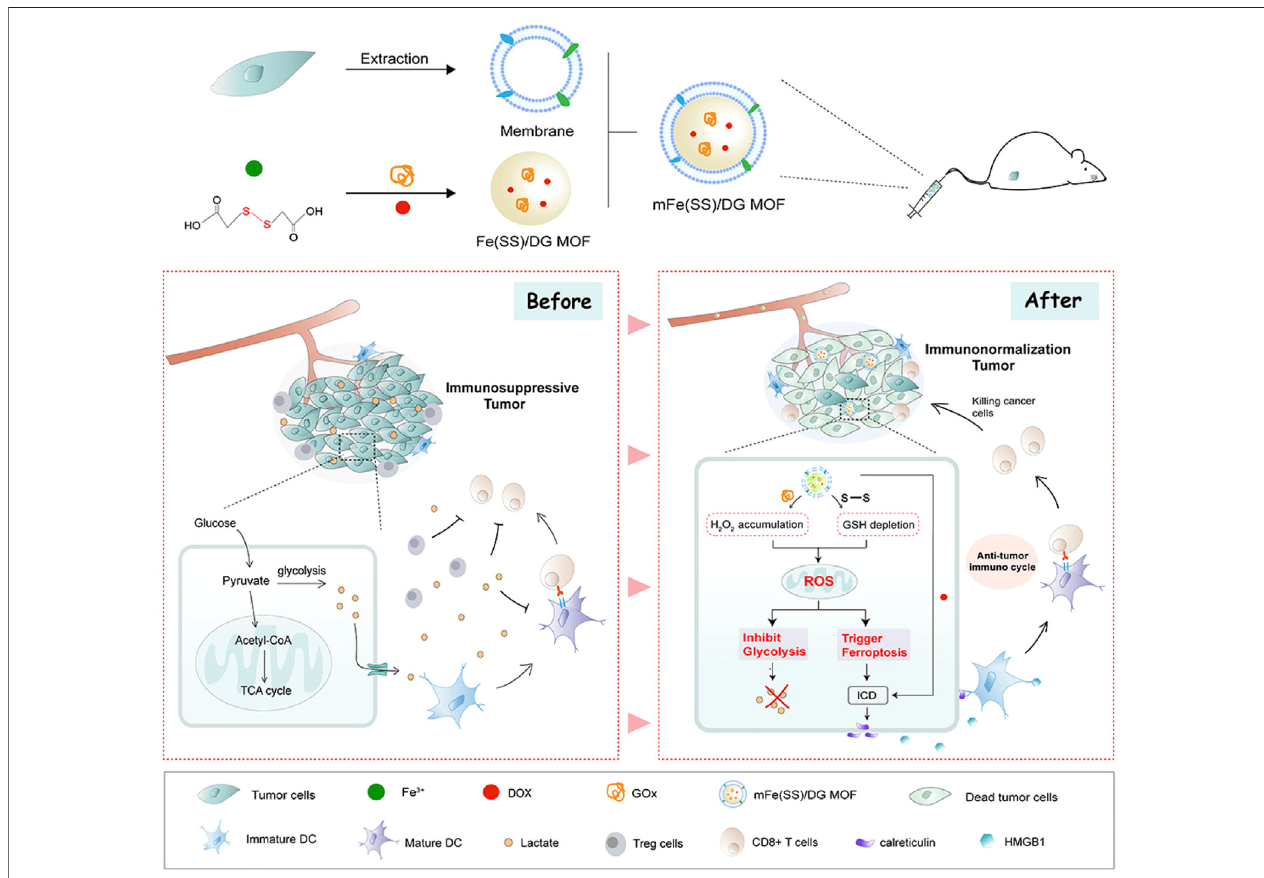
FIGURE6| SchematicillustrationofmFe(SS)/DGandthemechanismbasedonferroptosis – glycolysisregulation.AdaptedfromYangJetal.,(2021);YangYetal., (2021) Copyright @ 2021 (Elsevier).